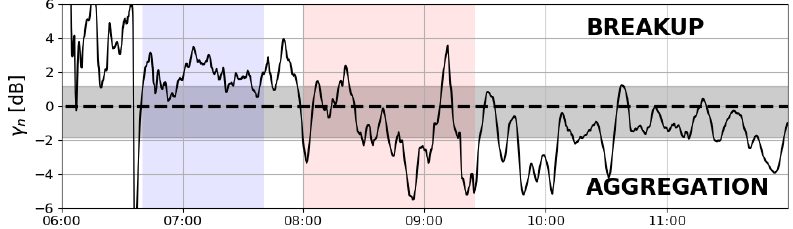
Figure 7. The normalized ratio between the reflectivity fluxes in ice and rain in the vicinity of the melting level as defined by Eq. (9).The grey shading highlights the uncertainty introduced by the variability in the vertical